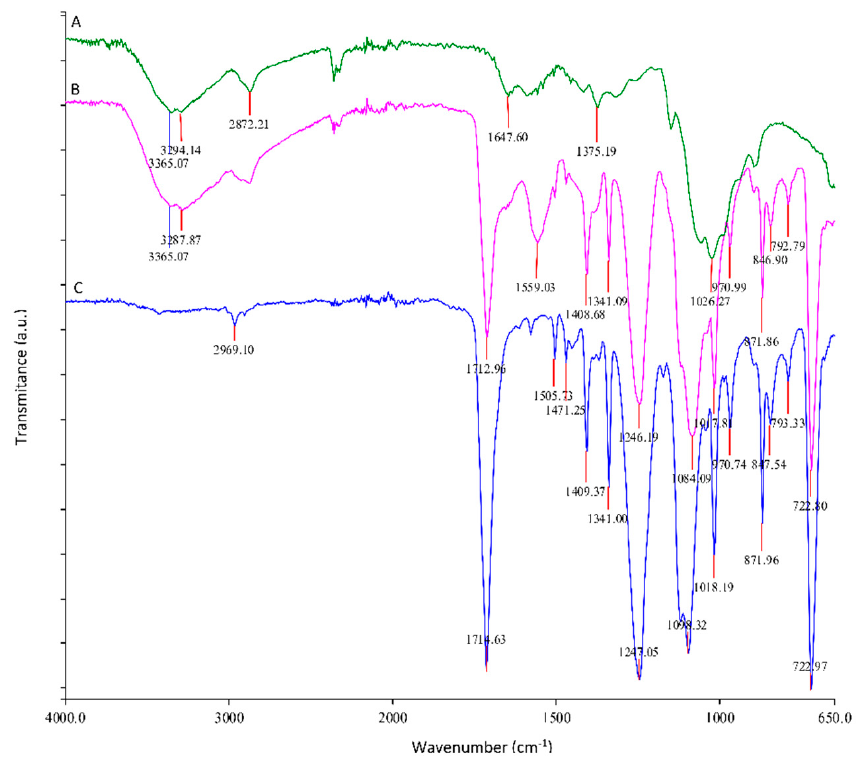
Figure 2. ATR–FTIR spectra of PET foil (C spectrum), commercially available chitosan (A spectrum), and functionalized PET foil by chitosan (PET–CHT) (B spectrum).